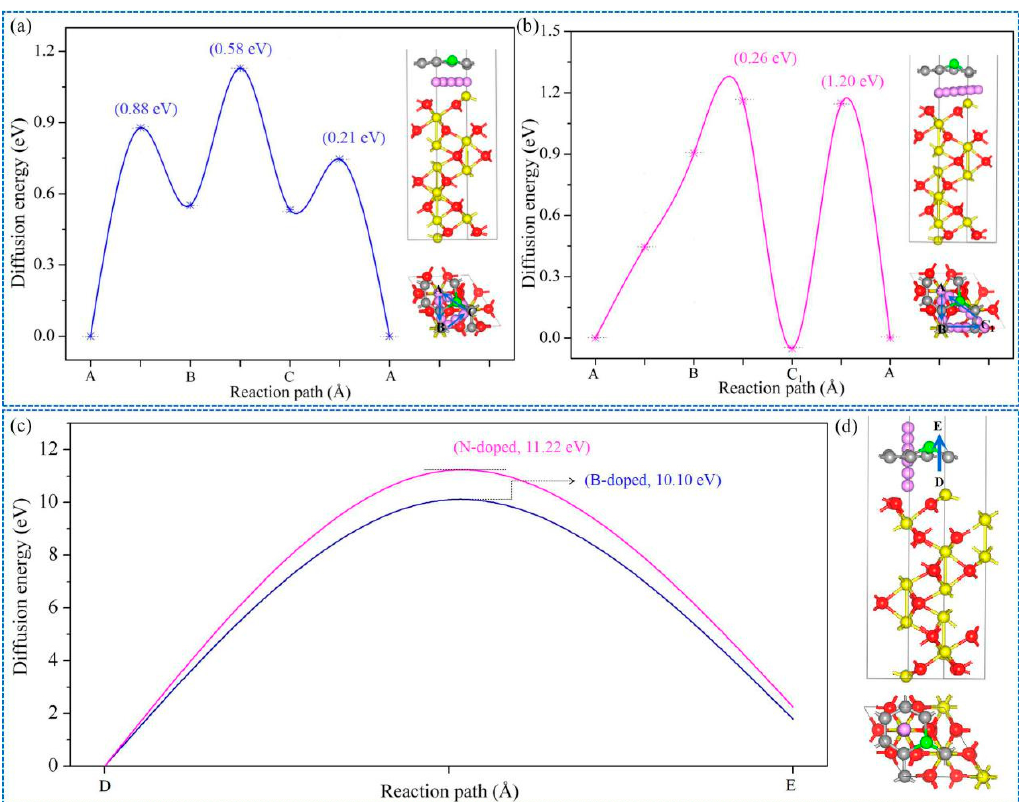
Figure 8. Energy barrier profiles for Li atom from A to B, B to C (C1), and C (C1) to A in ( a ) B- and ( b ) N-doped Gr/Fe-O 3 -Fe-R system; ( c , d ) energy barriers and diffusion paths for Li atom from D to E in B and N-doped Gr/Fe-O 3 -Fe-R.